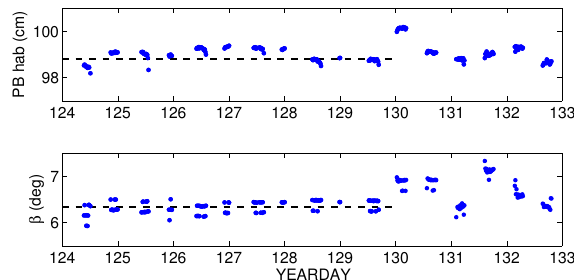
Figure 15. (a) Pencil-beam height above mean bed level. The dashed line indicates the 98.8 cm pre-storm average height. (b) Local bed slope, β , from the pencil-beam profiles. The quantization of the β values within a given tidal cycle is due to the 0.225 ◦ rotary sonar step size. The dashed line indicates the 6.3 ◦ pre-storm average.